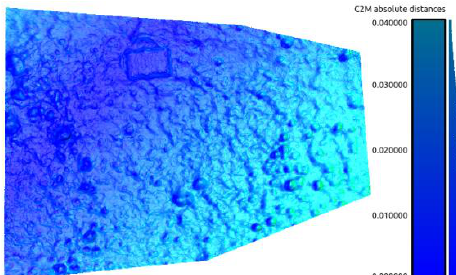
Figure 10. Evaluation of a 3D reconstruction standard photogrammetry pipeline with auto calibration setting